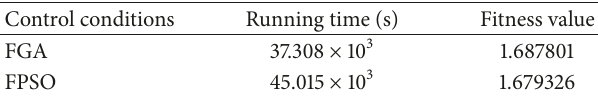
Table 6: Running time and fitness of the two optimization algo-